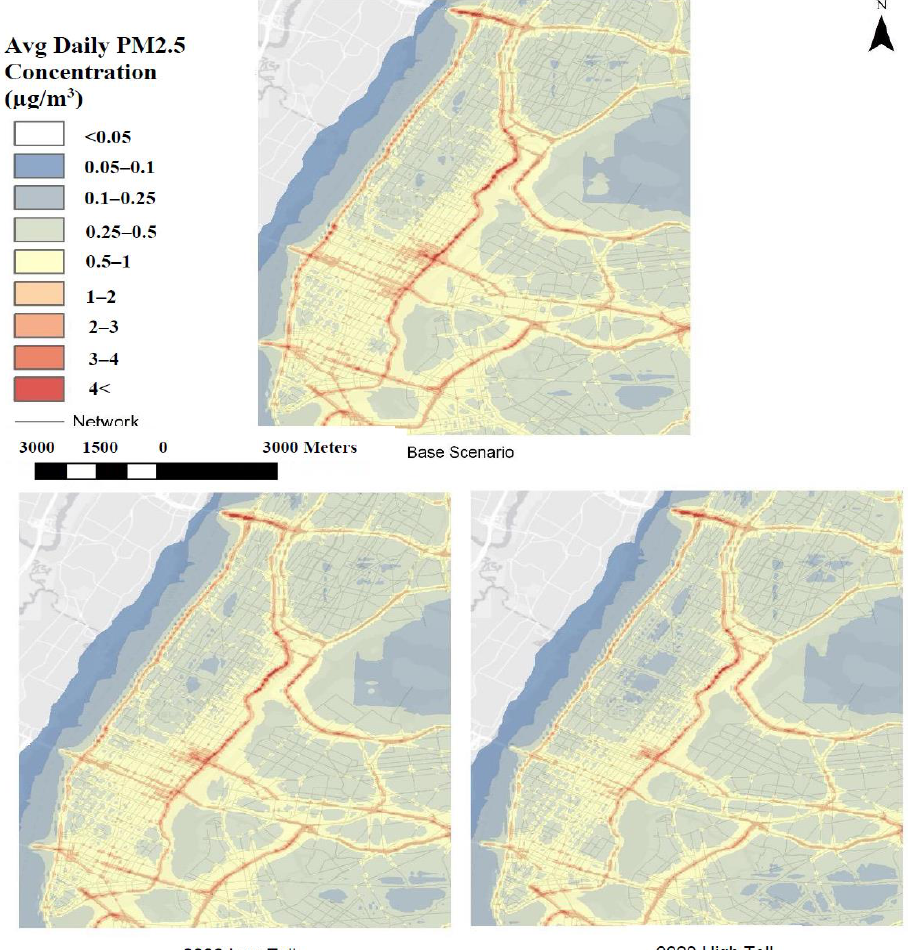
Figure 8. Pricing scenario impact on PM2.5 concentration .